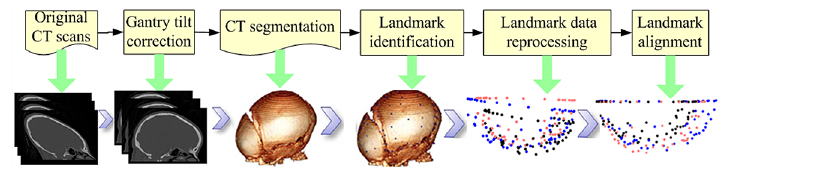
Fig 1. Procedure of CT data processing.